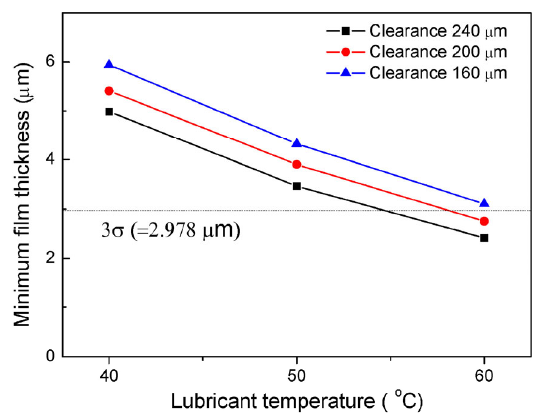
Fig. 11 Minimum film thickness with three different lubricant temperatures for the crank pin bearing with three different